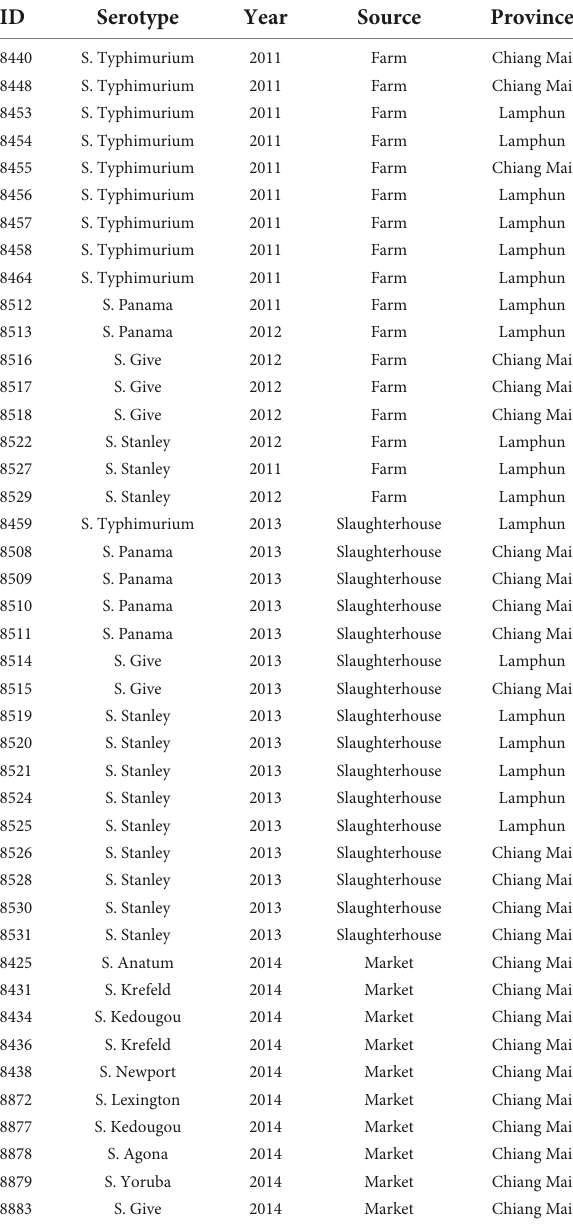
TABLE 1 Origin and characteristic of S. enterica isolates tested recovered from farms, slaughterhouses and retail markets during the period of